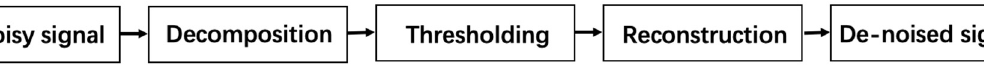
Figure 2. Steps of the wavelet de-noising algorithm.